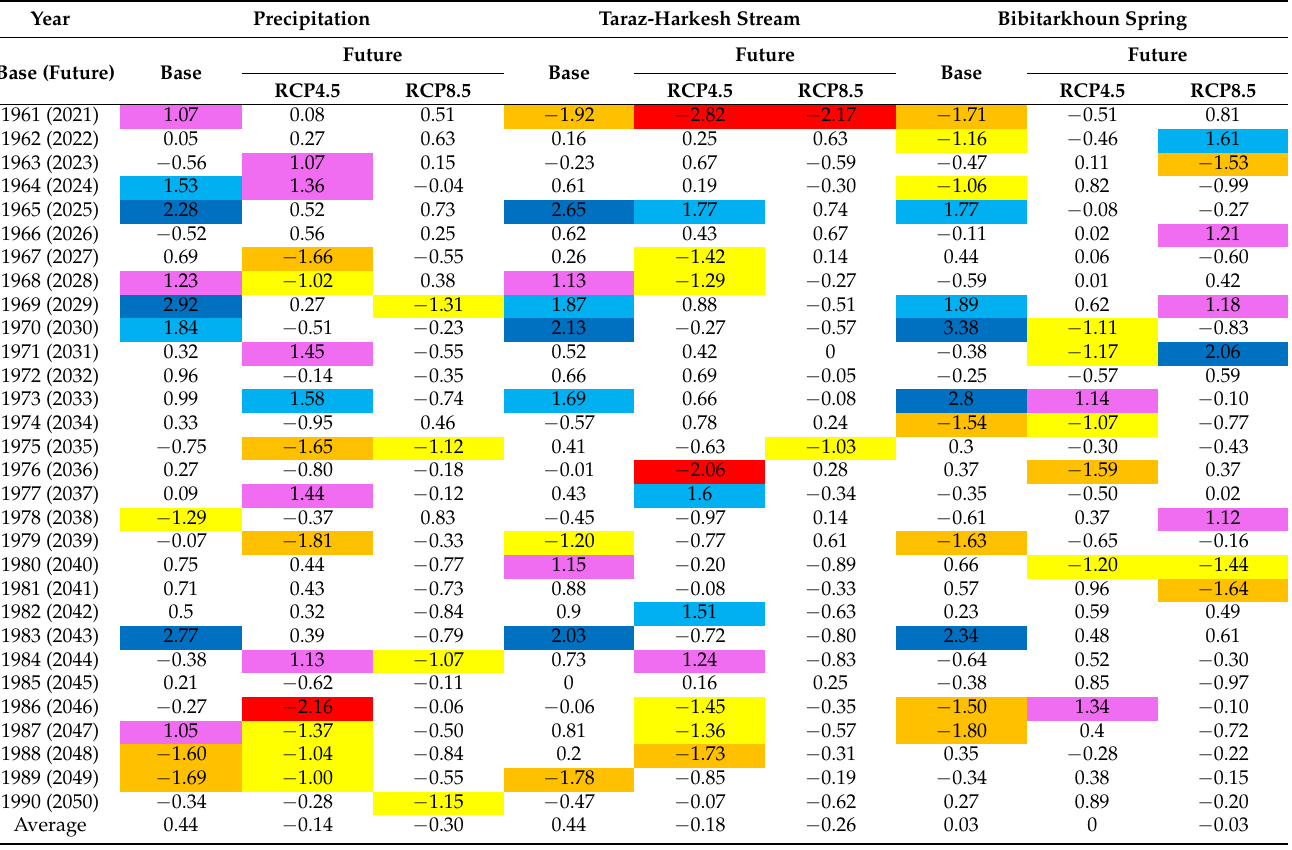
Table 3. The SPI, the SSWDI of the Taraz-Harkesh stream and the SGLDI of the Bibitarkhoun karst spring in the base and future time periods, considering RCP4.5 and RCP8.5 (uncolored cells indicate normal ( − 0.99 to 0.99), yellow cells indicate relatively dry ( − 1 to − 1.49), orange cells indicate